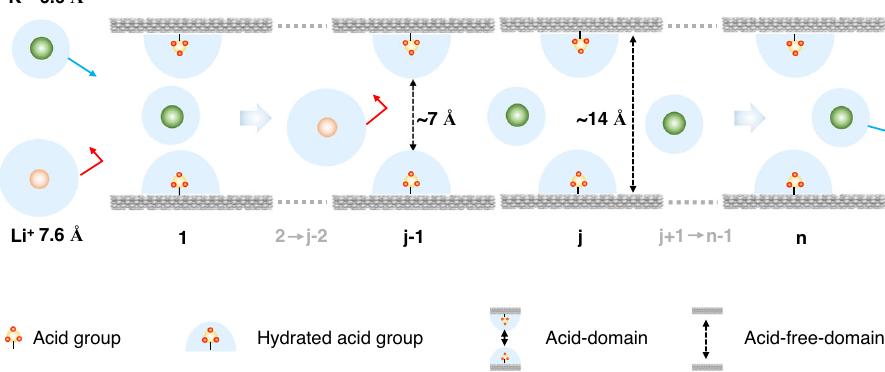
Fig. 1 |Schematicillustrationofcon fi nedcascadeseparation. The acid domains strongly bind with water molecules to form hydration shells, serving as con fi ned stagetonarrowthemasstransportchannels.Thecascadecon fi nedstagesalongthe